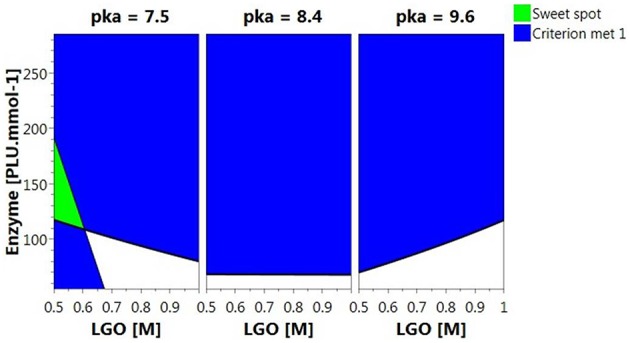
4D Sweet Spot plot. Green color indicates the “sweet spot,” where both responses are at least 80%; blue indicates the area where the criteria fails for one of the responses and white indicates the area where none of the responses are within the selected range.